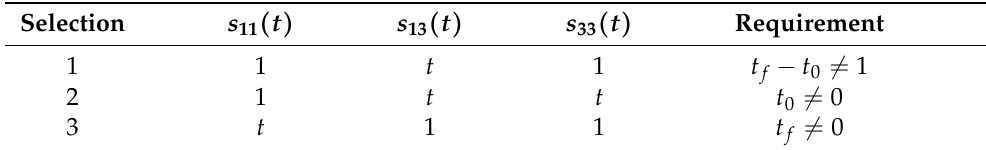
Table 1. Examples of supports function